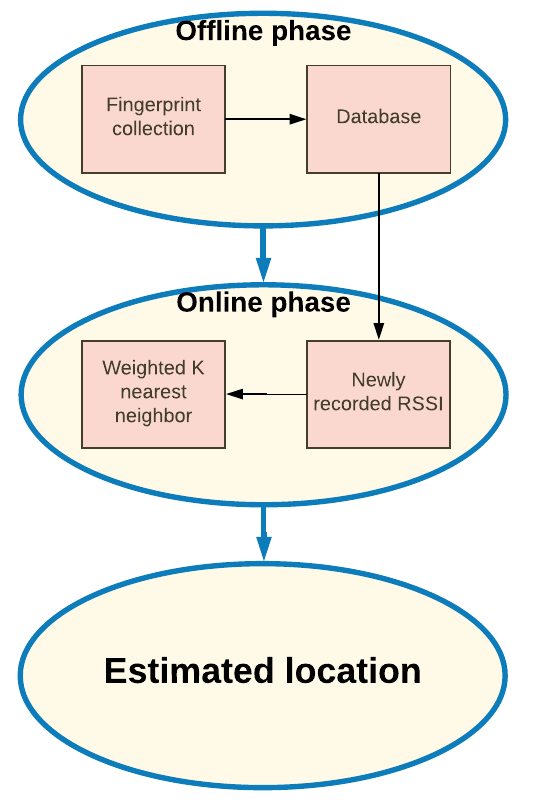
Figure 2. WIFI fingerprinting positioning system